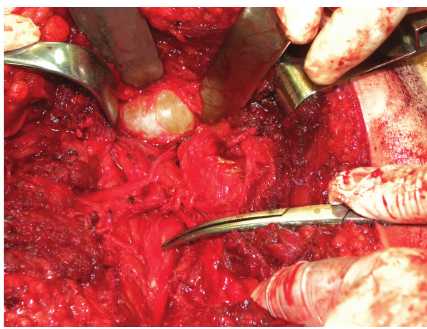
Figure 2: Intraoperative photograph of the lesion. Clamp shows sciatic nerve.